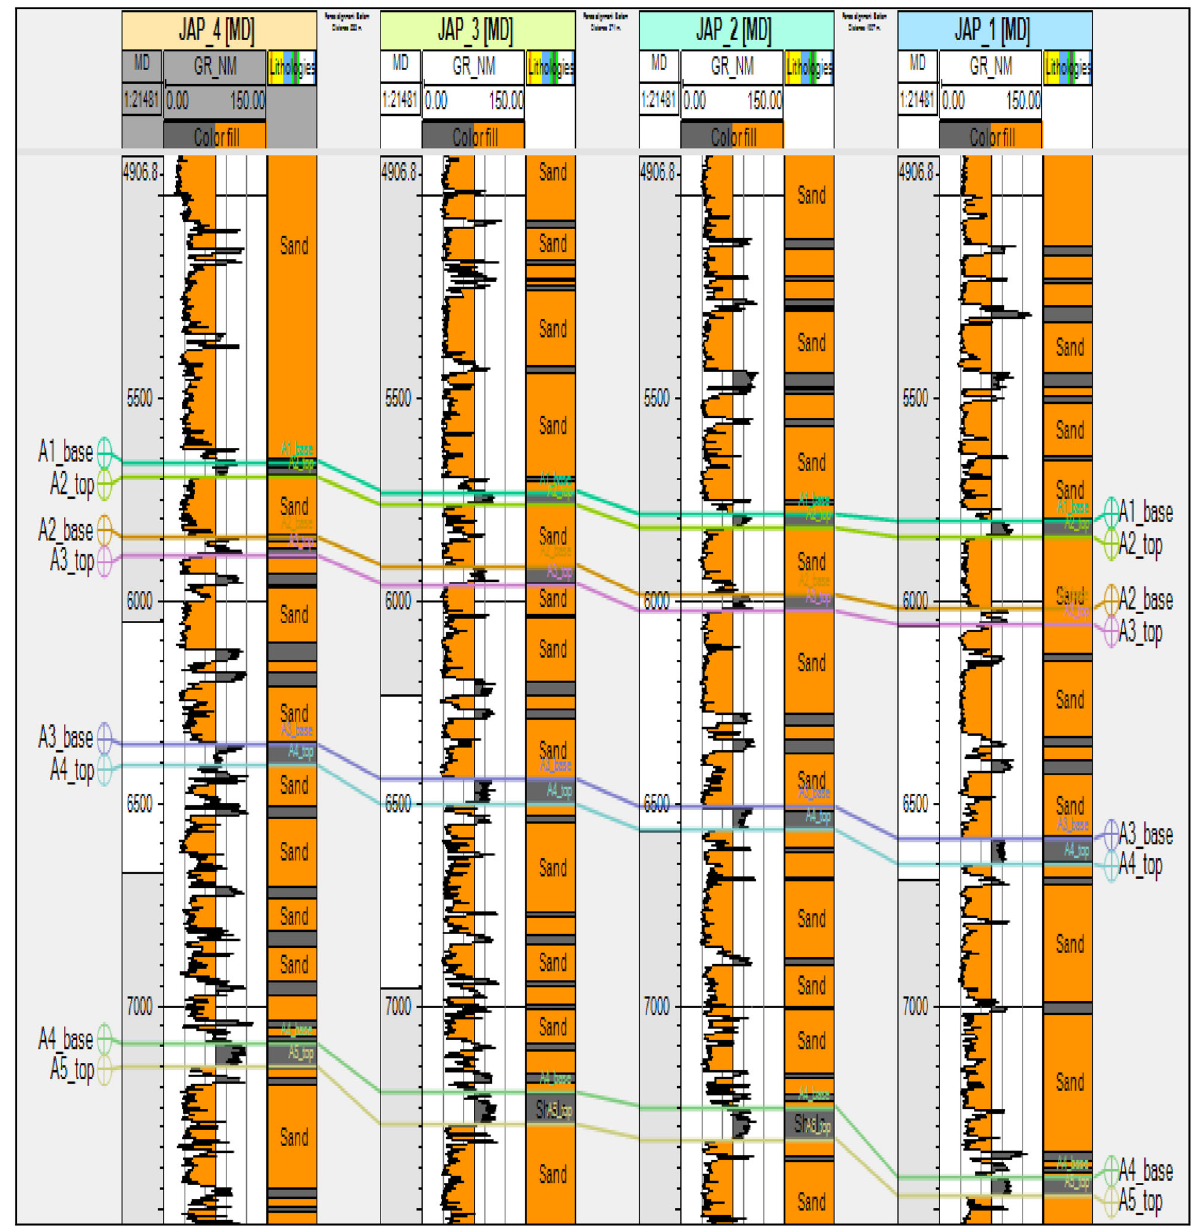
Fig. 3 Correlation panel of reservoirs A1–A4 in the wells across